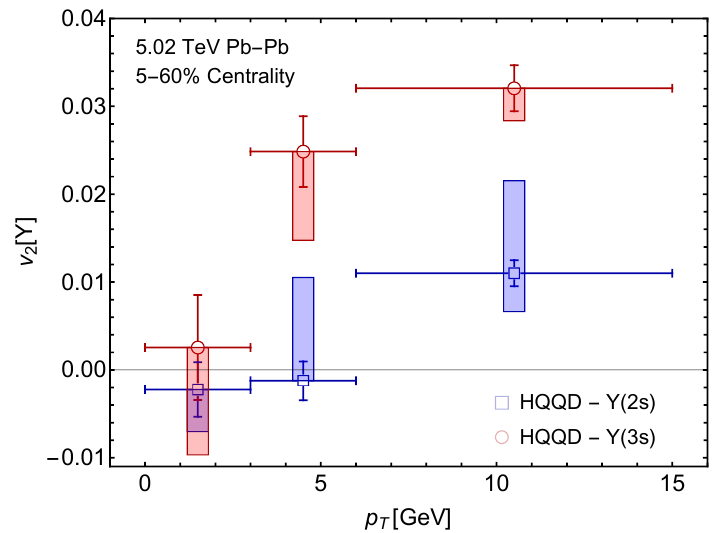
Figure 9 . HQQD predictions for the elliptic flow of Υ(2 s ) and Υ(3 s ) states in the 5–60% centrality bin. The transverse momentum bins are the same as used in figure 6. The shaded red and blue boxes associated with each HQQD prediction indicate the systematic variation observed when changing the model parameters in the range specified in eq.